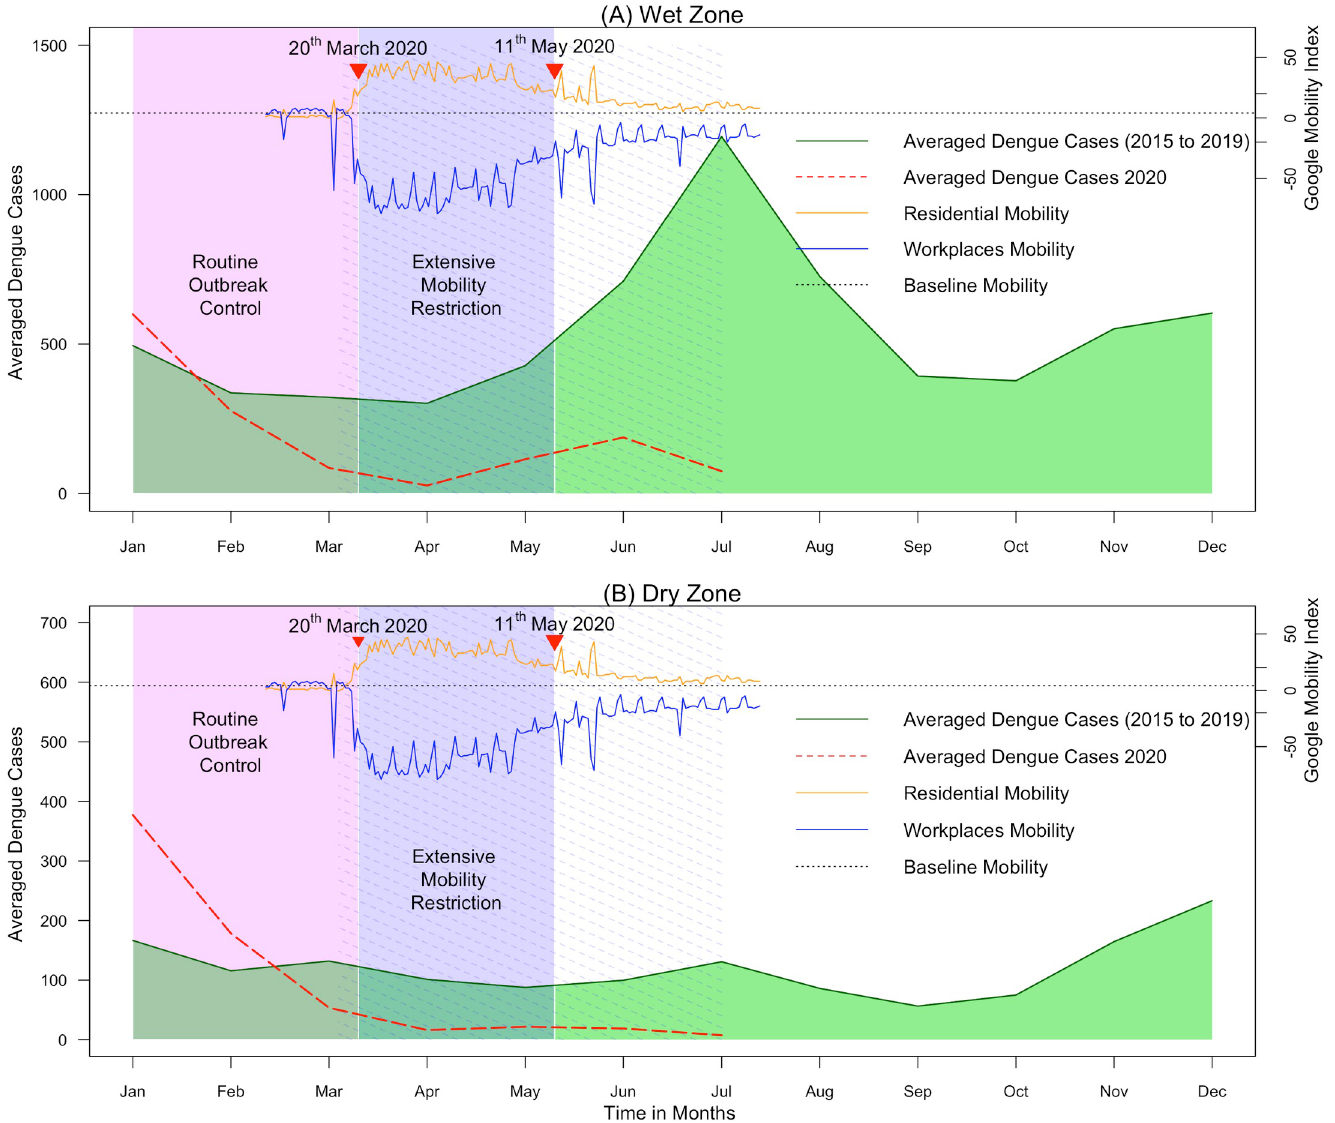
Fig 2. Reported dengue cases during 2020 compared to monthly averaged dengue cases reported from 2015 to 2019 averaged across all districts in climate zones in Sir Lanka. (A) Wet zone. (B) Dry zone. The green solid line shows the five-year average. Red dashed line shows cases reported during 2020. The purple solid area indicates the period of extensive mobility restriction; the purple dashed area indicates the period of school closure; the pink area indicates the period of routine dengue outbreak control interventions. The residential mobility represents the percentage change of daily mobility compared to the baseline residential mobility; the workplace mobility represents the percentage change in daily mobility compared to the baseline workplace